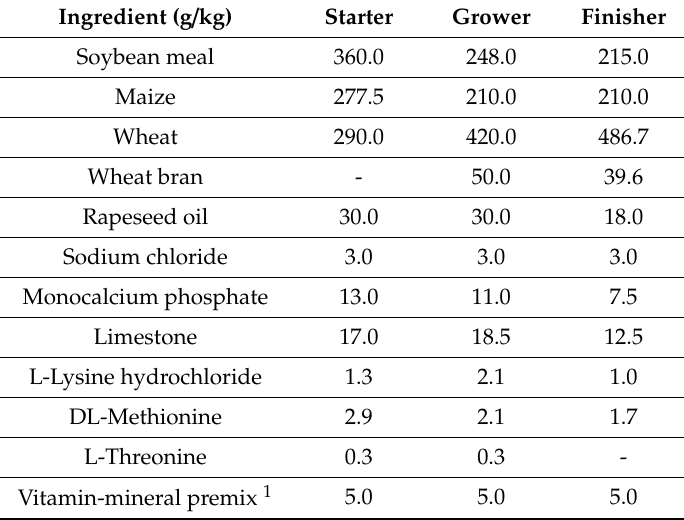
Table 1. Ingredients of the